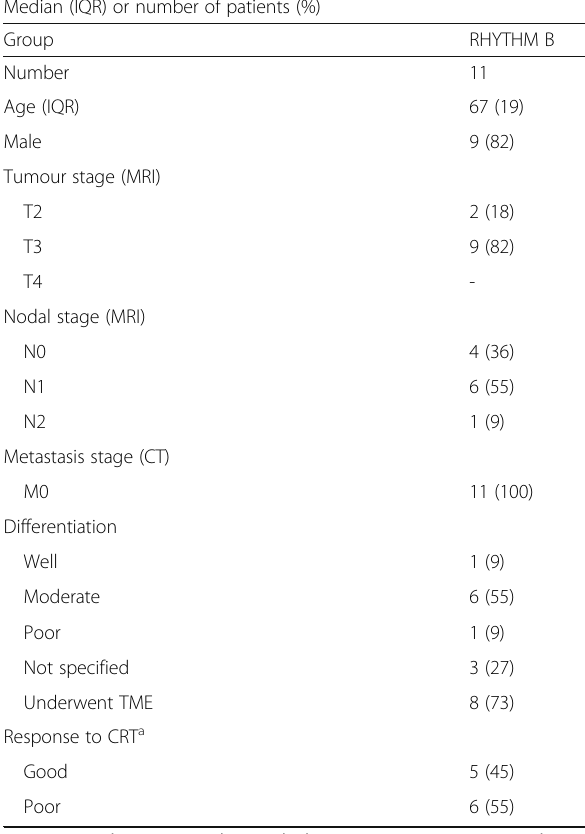
Table 1 Patient characteristics for RHYTHM study Median (IQR) or number of patients